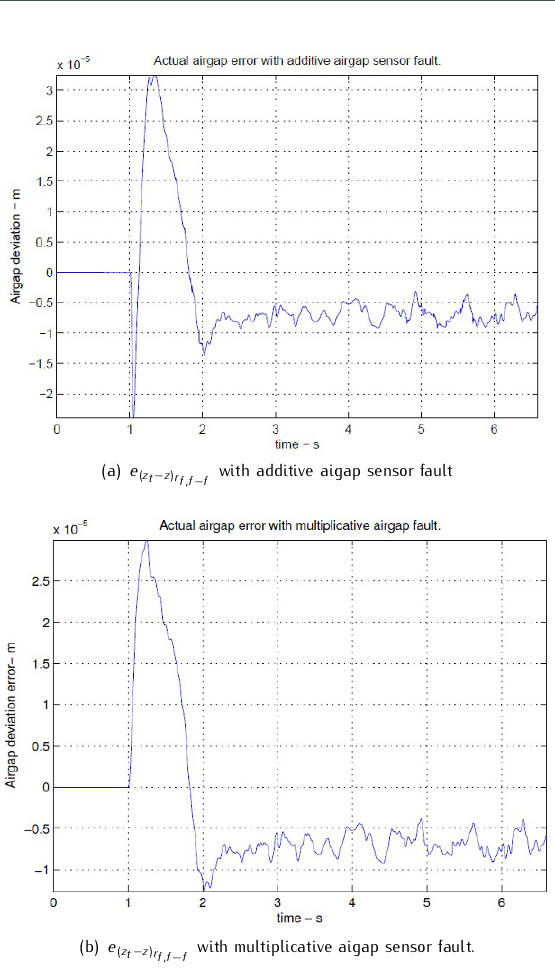
Figure 16. Error between the real airgap with airgap sensor fault and fault-free ( e ( zt−z ) rf,f−f )